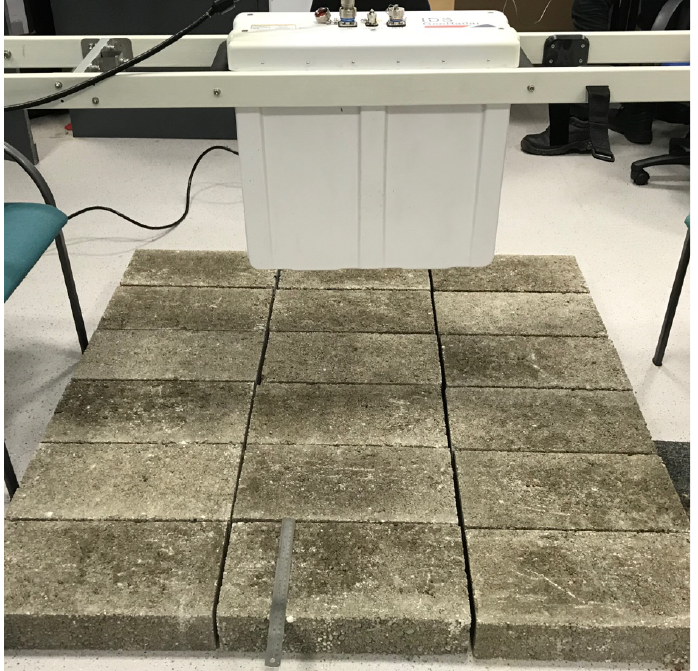
Figure 7. The experimental framework used to validate the revised shape factor. A horn antenna with 1 GHz central frequency is placed on top of a surface consisted of concrete blocks. The gaps between the concrete blocks are gradually increased in an effort to increase the overall volumetric fraction of